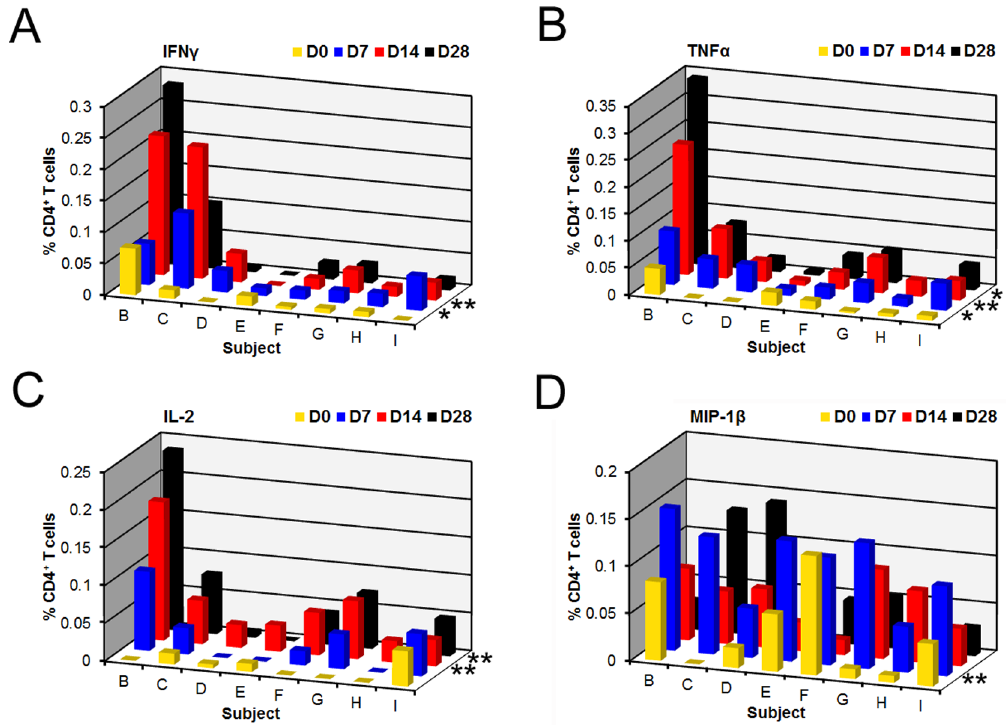
Figure 1. Proinflammatory cytokines and a chemokine are produced with specific kinetics post-primary infection with C.jejuni . We analyzed CD4 + T cells for the production of IFN c + , TNF a + , IL-2 + , and MIP-1 b + for eight subjects challenged with C. jejuni at multiple timepoints pre- and post-primary infection. Responses shown are the percentage of cytokine positive CD4 + T cells from CAg-stimulated PBMCs with the background percentage of cytokine-positive T cells in the negative control (PBS) subtracted. CD4 + T cells producing each cytokine were reported for 3 time-points post-challenge: D7 (blue), D14 (red), and D28 (black). A) CD4 + IFN c + T cells; B) CD4 + TNF a + T cells; C) CD4 + IL-2 + T cells; and D) CD4 + MIP-1 b + T cells. An asterisk denotes a significant difference between a response on a post-challenge day and D0 (yellow): * P , .05 and ** P , .01. Statistics were determined using repeated measures analysis of variance were not available for Subject B after re-infection.